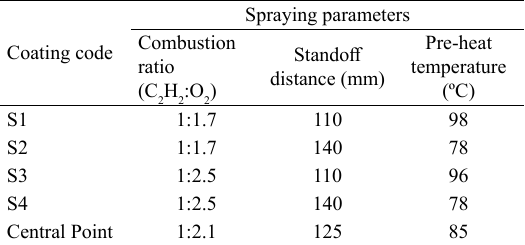
Table 2. Spraying parameters used to manufacture the Top Coats according to the factorial Design of